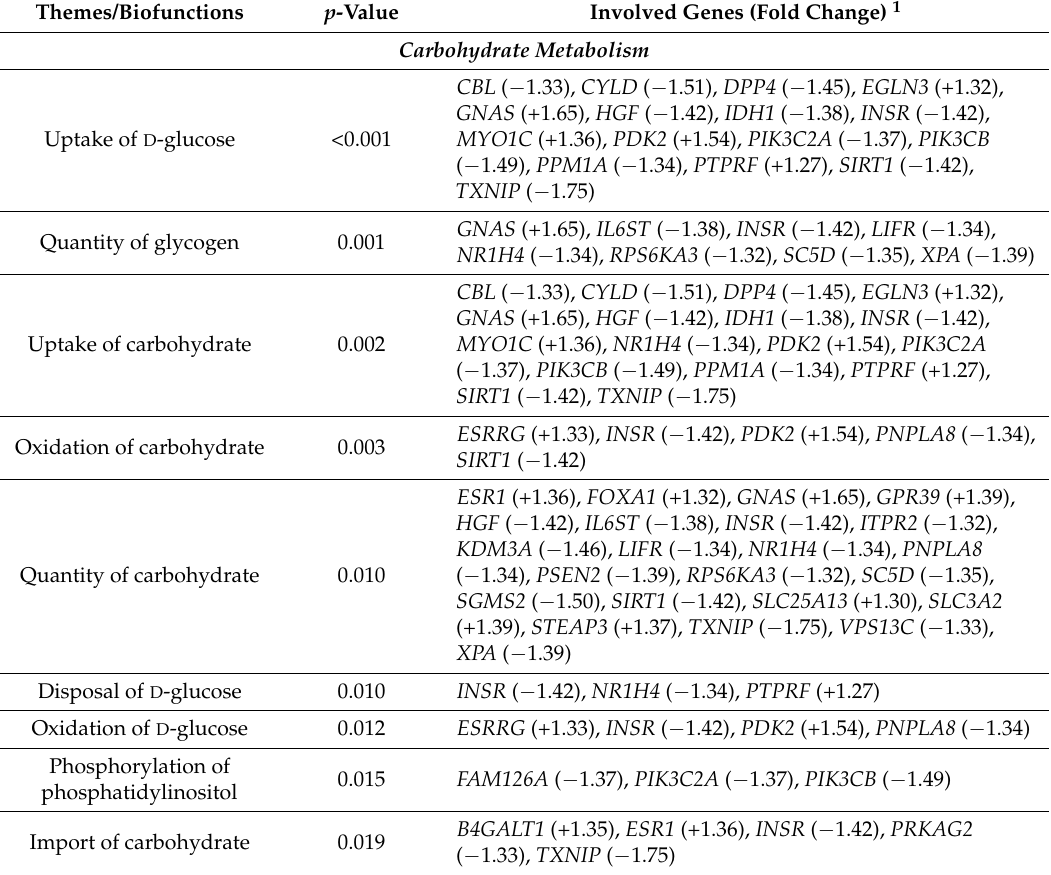
Table 4. Significantly enriched bio-functions of carbohydrate, lipid, and amino acid